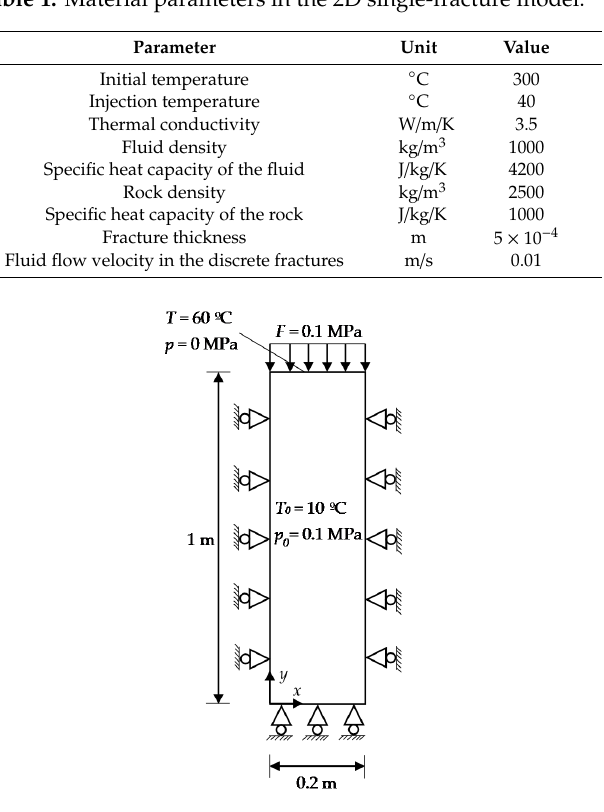
Figure 9. Schematic of thermal consolidation problem. Table 2. Material parameters in the thermal consolidation